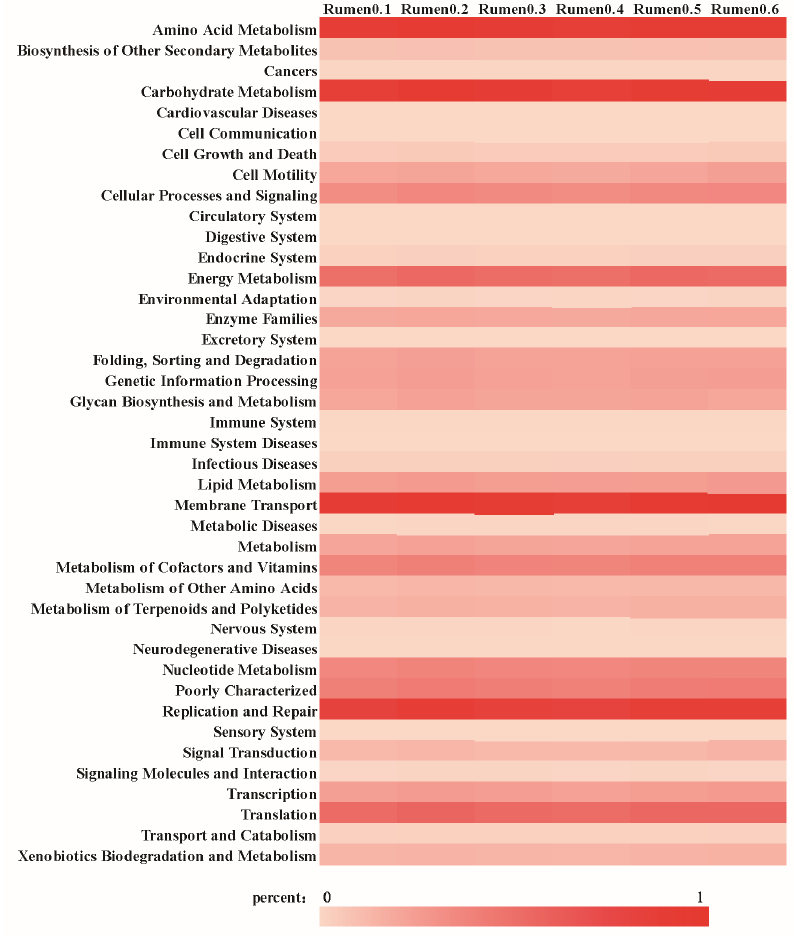
Figure 4. Prediction of rumen flora in the secondary pathway of Kyoto Encyclopedia of Genes and Genomes (KEGG). Notes: Rumen0.1, Rumen0.2, Rumen0.3, Rumen0.4, Rumen0.5 and Rumen0.6 represent the name of six rumen contents samples. Details about the samples are shown in Table A1 (Appendix A). Table 8. Number of operational taxonomic units (OTUs) relate to aromatic compounds in Kyoto Encyclopedia of Genes and Genomes (KEGG) function annotation .